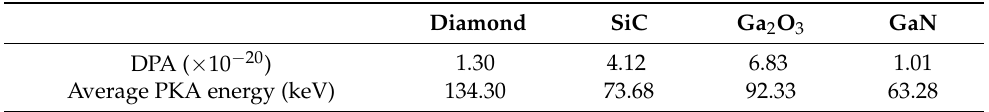
Table 6. Displacements per atom and average primary knock-on atoms energy of four materials under a 1 MeV neutron